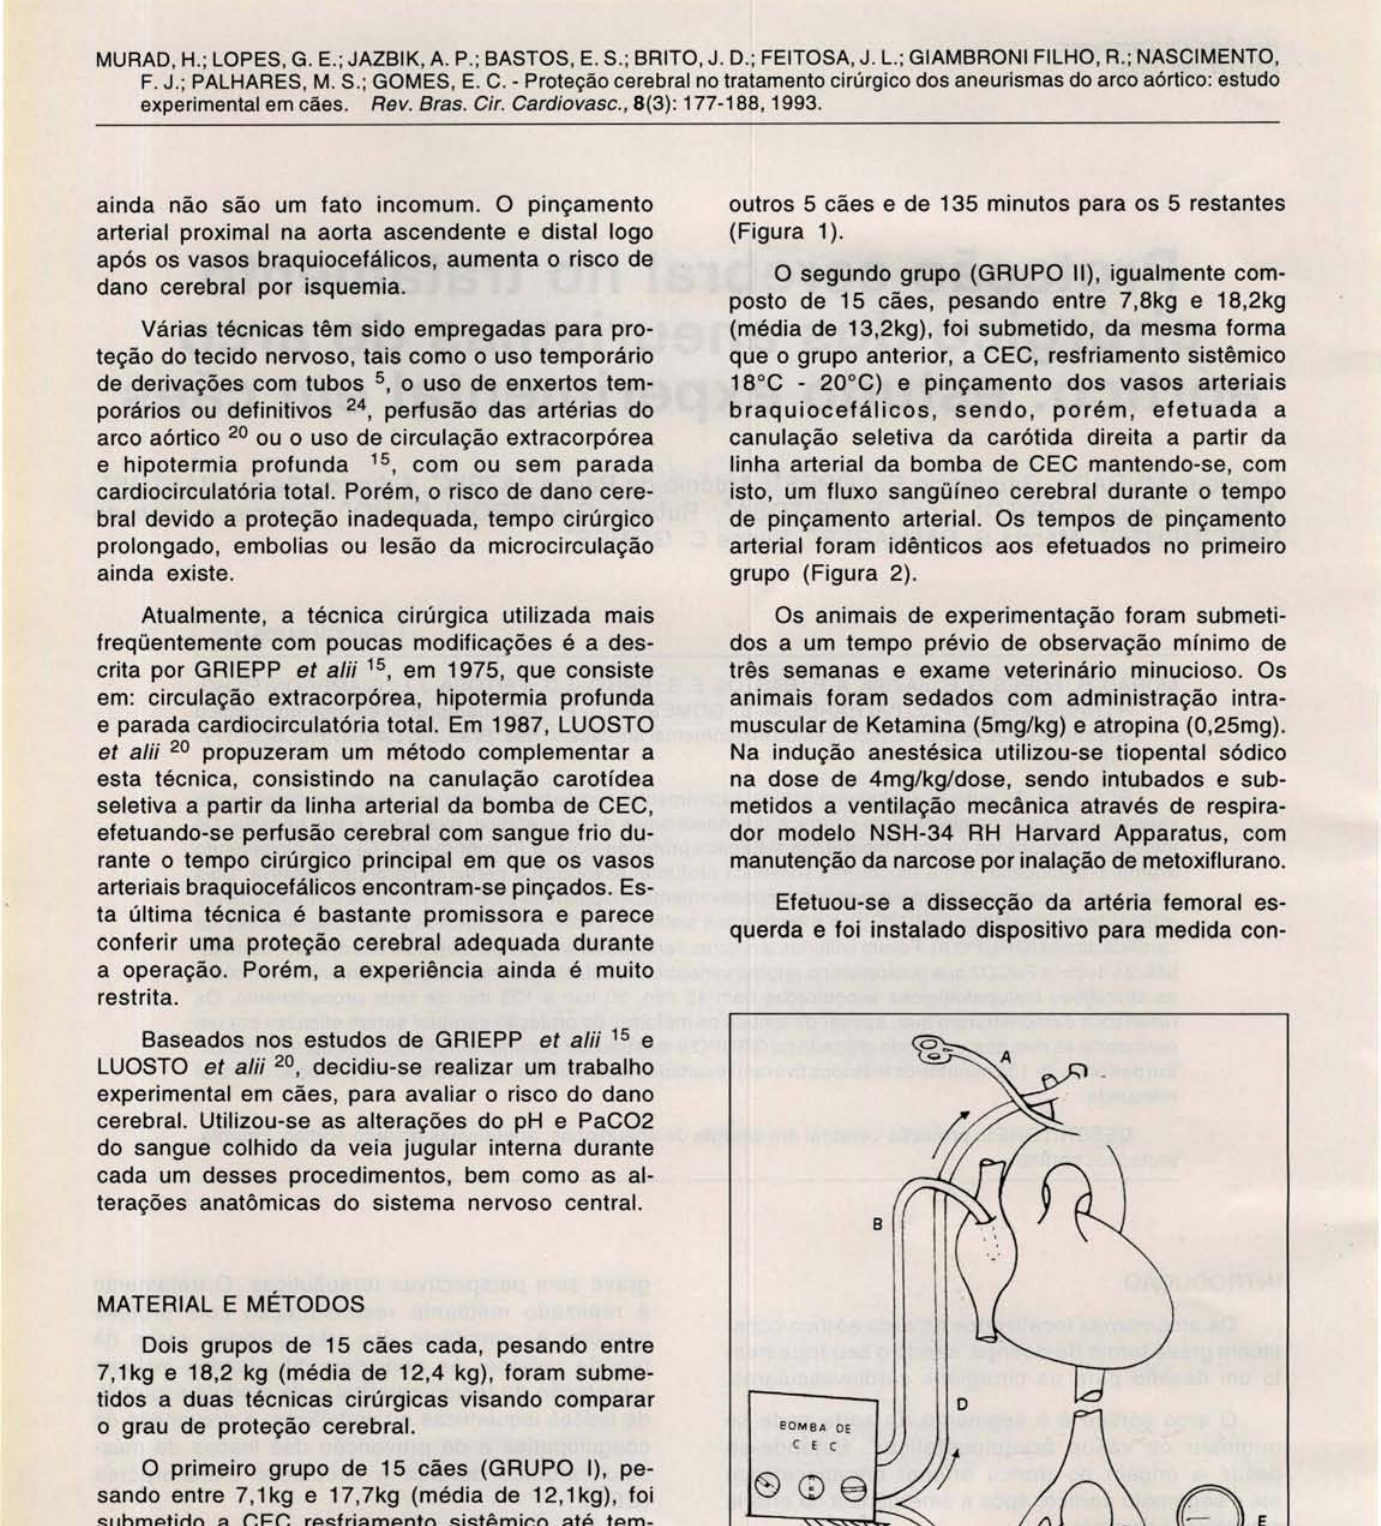
Fig. 1 - Esquema da técnica cirúrgica empregada no Grupo I. A: pinçamento dos vasos arteriais braquiocetálicos; B: drena gem venosa do átrio direito; C: linha arterial proveniente da bomba de CEC instalada emartéria temoral dirMa; O: monitoração contínua de pressão média em artéria temoral